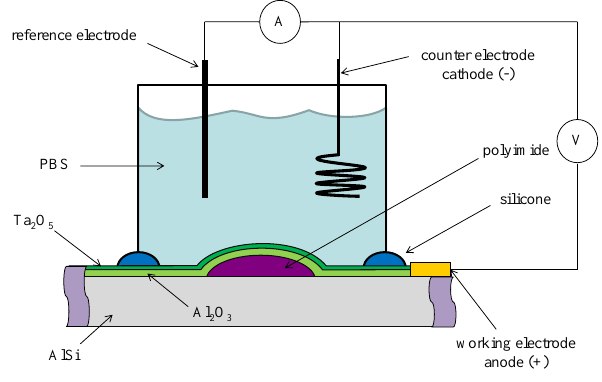
Figure 10. Schematic representation of the test setup for the am- perometric defect investigation.